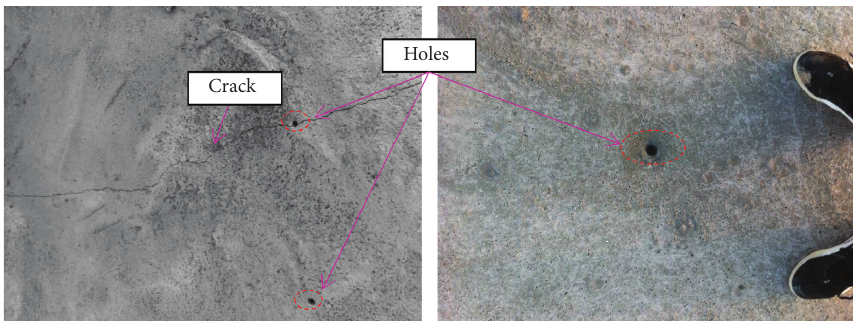
Figure 1: Damage to foamed concrete structures caused by hydration